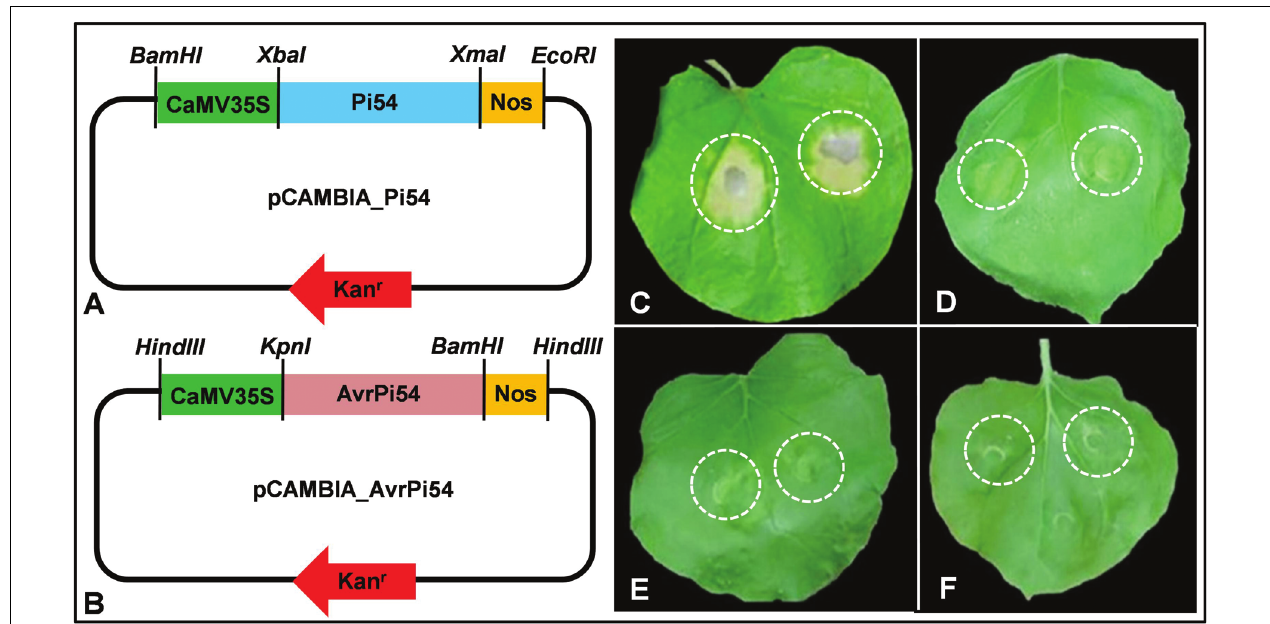
FIGURE 3 | Tobacco leaf infiltration assay demonstrates HR induction in response to direct physical interaction between Pi54 and candidate AvrPi54 proteins. Line diagrams represent Pi54 expression module (A) and AvrPi54 expression module (B) used for agroinfiltration. HR symptoms were observed when Pi54 and AvrPi54 expression modules were co-infiltrated in tobacco leaf (C) . Neither AvrPi54 expression module nor Pi54 expression module produced HR when infiltrated individually ( D,E , respectively). Empty pCAMBIA vector (negative control) also did not induce HR upon infiltration (F) . The sites of agroinfiltrations in the tobacco leaves are marked by white dashed